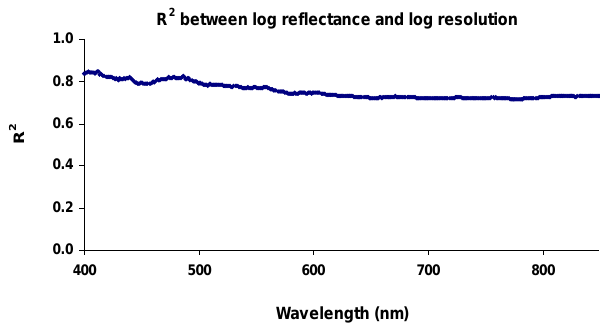
Fig. 3. R 2 between log reflectance and log resolution between 400– Fig. 3 – R 2 between log reflectance and log resolution between 400-850 nm, obtained on 850nm, obtained on 12 August 2007, in site 106 ( n = 5, signifi- August 12, 2007, in site 106 (n = 5, significance level < 0.05, and critical value R 2 > 0.65). cance level < 0 . 05, and critical value R 2 > 0 .